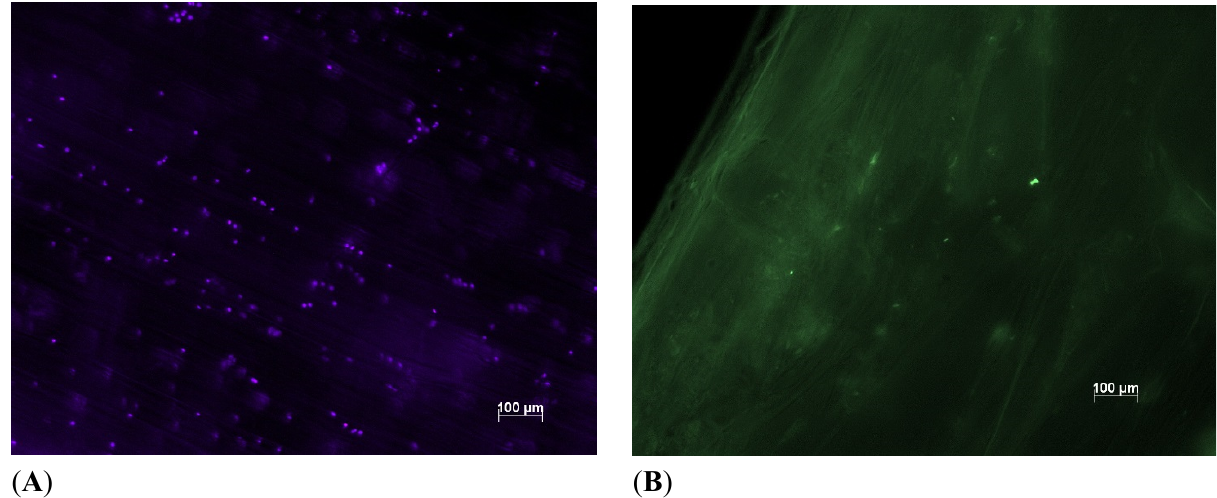
Figure 5. Fluorescence micrographs showing intercellular colonization of mkate -tagged strain WP19 in the root tissue of the inoculated seedling of Douglas-fir ( A ) and GFP-tagged strain WP5 in the needle of the inoculated Douglas-fir ( B ). Samples were surface-sterilized and visualized (1000×) three weeks after